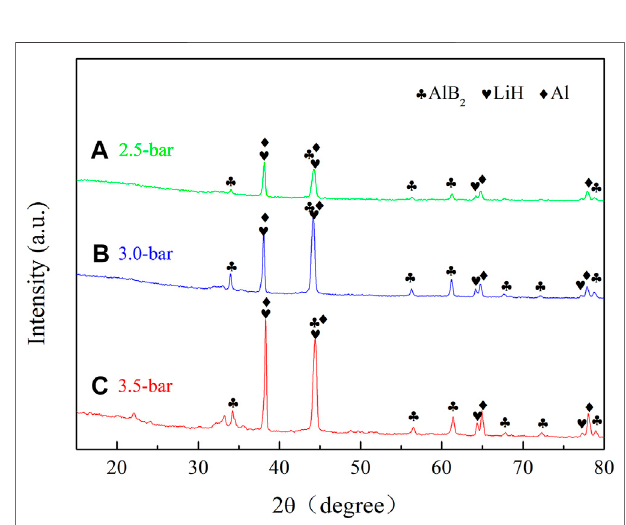
FIGURE 9 | XRD patterns of the second cycle dehydrogenation products of TiF 3 -added 2LiBH 4 – Li 3 AlH 6 composites with different back pressures: (A) 2.5 bar, (B) 3.0 bar, and (C) 3.5 bar.